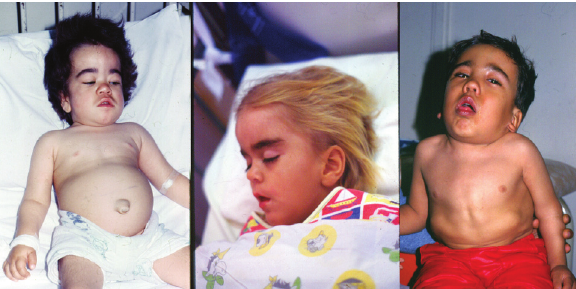
Figure 1 - Three distinct phenotypes in MPS diseases: left - MPS I patient showing visceromegaly and cognitive decline; center - MPS III B patient showing mental deterioration without major somatic fingings; right - MPS IV A patient showing skeletal dysplasia without coarse facies and visce- romegaly and with normal